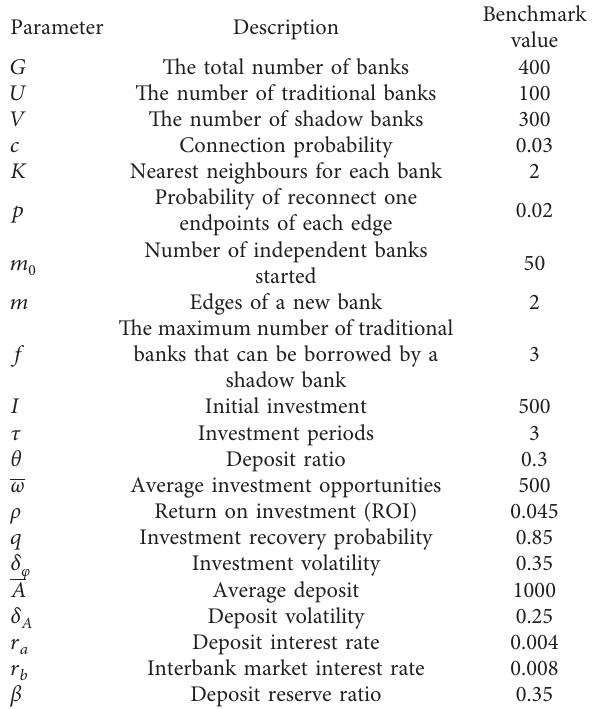
Table 1: Benchmark parameter of the